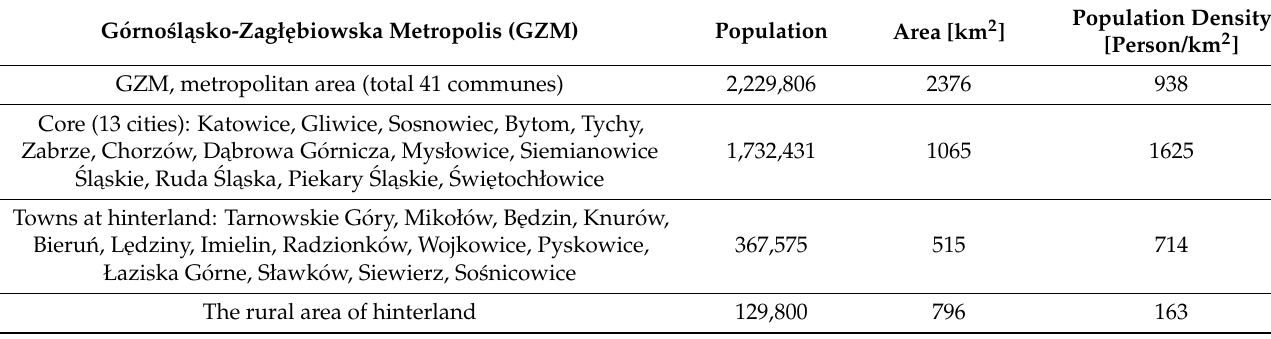
Table 1. Population and area of the GZM in 2018.